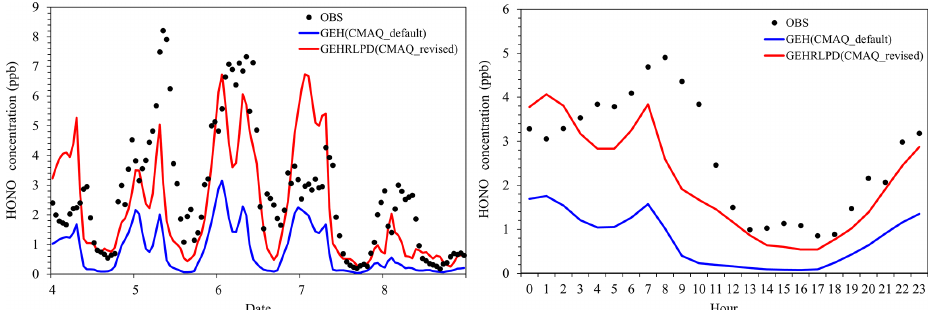
Figure 2. Observed and simulated HONO mixing ratios by the default and revised CMAQ model at the Heshan site during 4–8 January